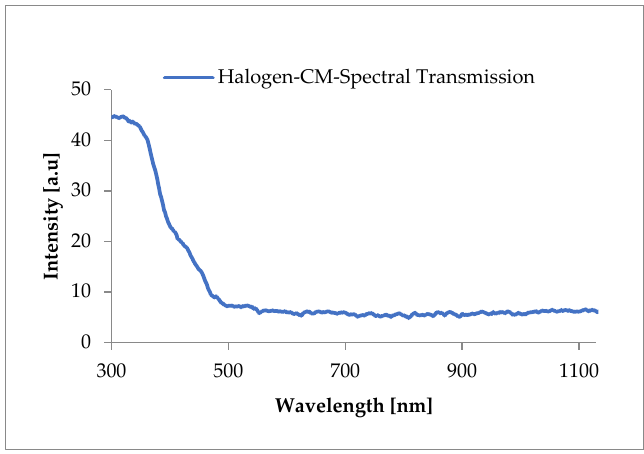
Figure 6. The halogen light spectrum transmitted by cold mirror (CM).